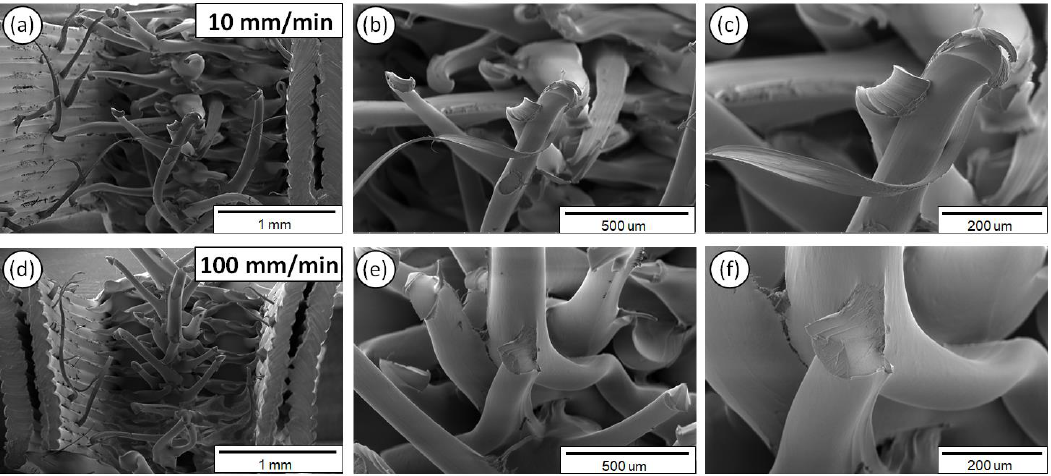
Figure 11. SEM images of PA6 fractured surfaces at three different magnifications for the 10 ( a,b,c ) and 100 mm/min ( d,e,f ) strain rates.